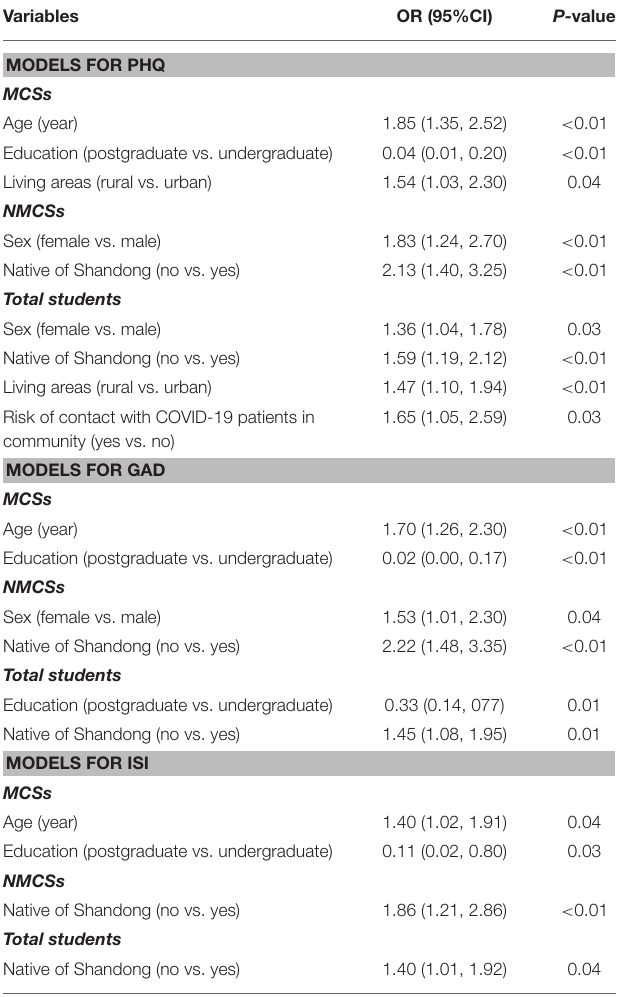
TABLE 4 | Outcomes of mental health